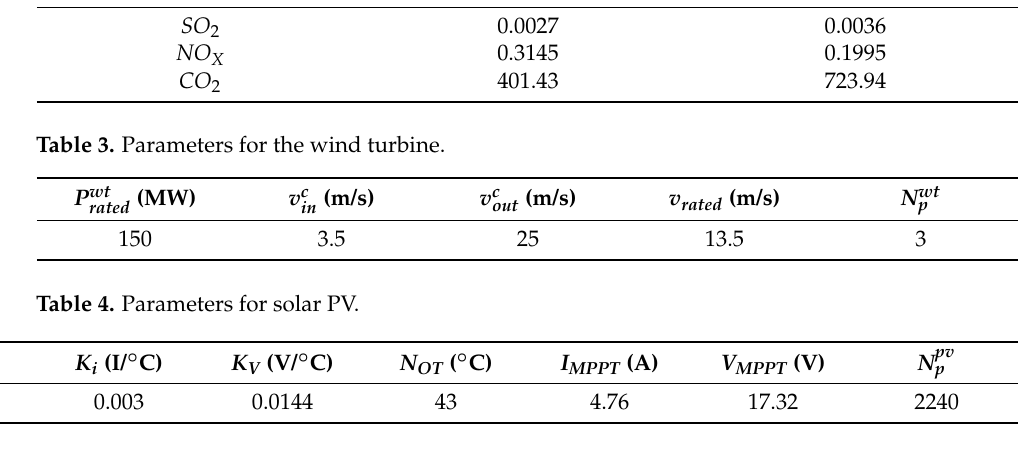
Table 5. Parameters for heat-only units.